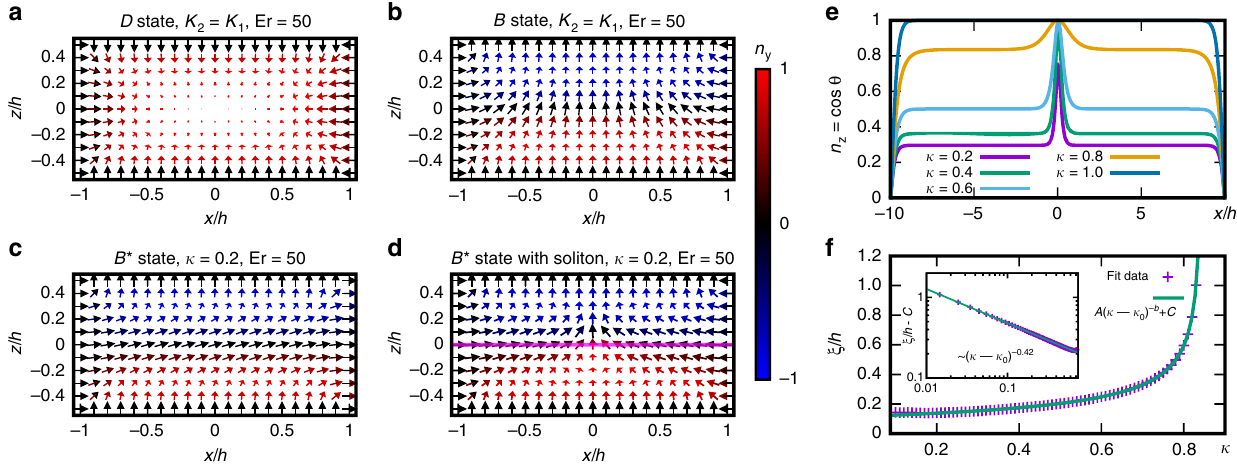
Fig. 7 Effects of fi nite channel width on the stability of fl ow-induced patterns. a – d 2D channel cross sections showing the director fi eld of states D in a , B in b , and B (cid:3) in c , d . The side walls force the director to point perpendicularly to the fl ow, inducing a chiral state near the wall. In B state, this chirality transitions to the achiral pro fi le away from the walls ( b ). In the B (cid:3) state, it is continued from the walls across the channel with either a single chirality ( c ) or with opposite chiralities, meeting at the soliton in the middle ( d ). e Vertical component n z ¼ cos θ of the director for different elastic anisotropy values κ sampled along the mid-line (magenta line in d ) shows the achiral soliton in the middle of the channel, where left- and right-handed B (cid:3) domains meet. f Critical behaviour of the soliton width ξ with respect to the elastic anisotropy κ . The inset shows the log-log plot of the power-law part of the expression, with the critical exponent b (cid:4) 0 :